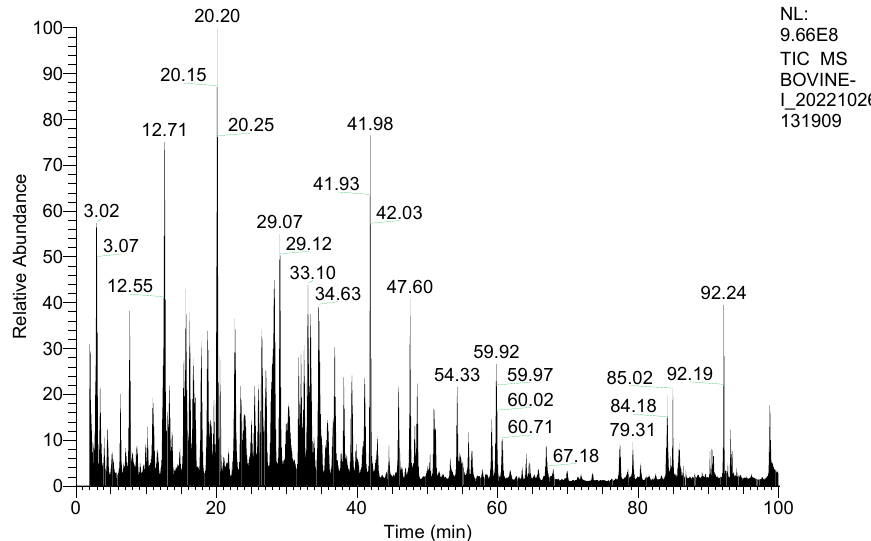
Figure 3. Total ion chromatogram of digested bovine type I collagen reference material.